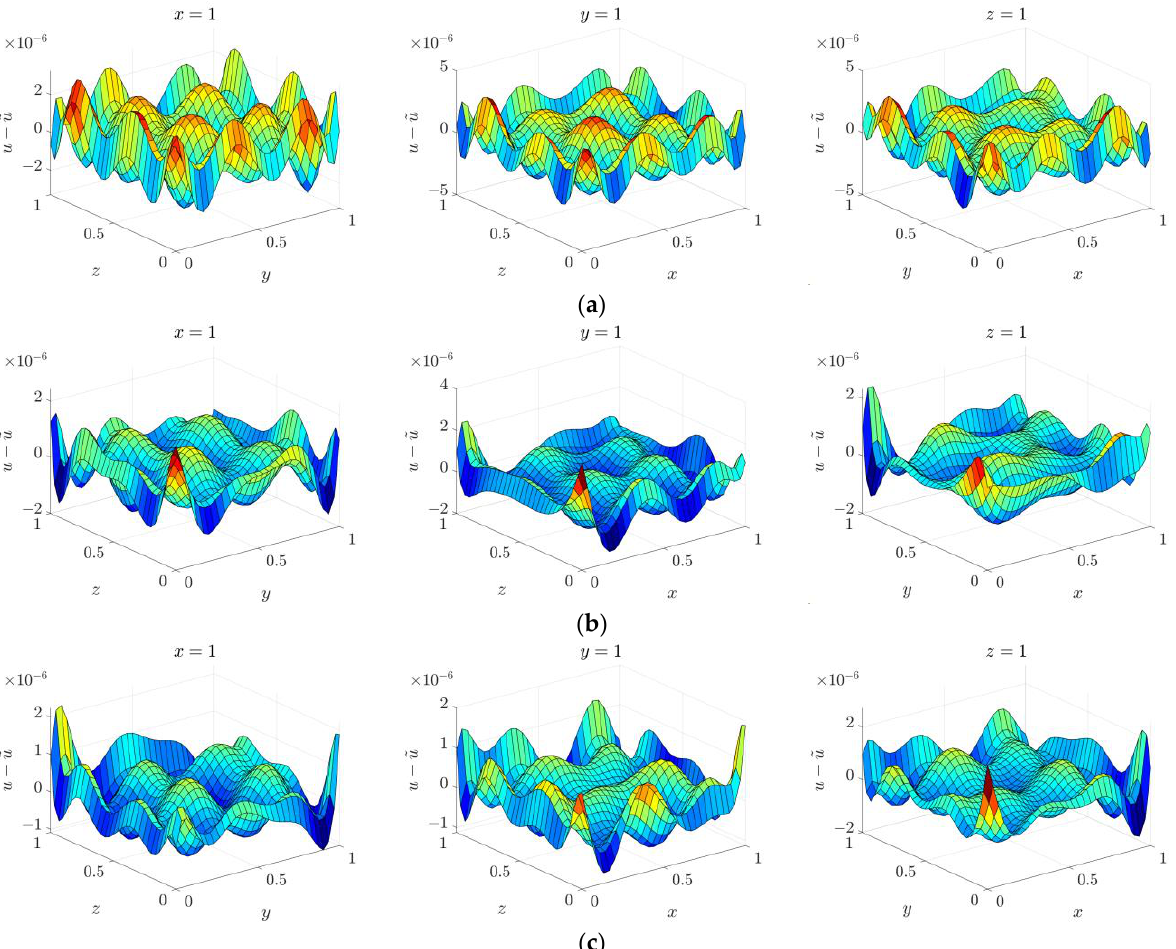
Figure 25. Errors of boundary solutions for the 3D parameter identification problem in cubic domain under different discretizations: ( a ) N s = 7 × 7 × 7; ( b ) N s = 9 × 9 × 9; ( c ) N s = 11 × 11 ×